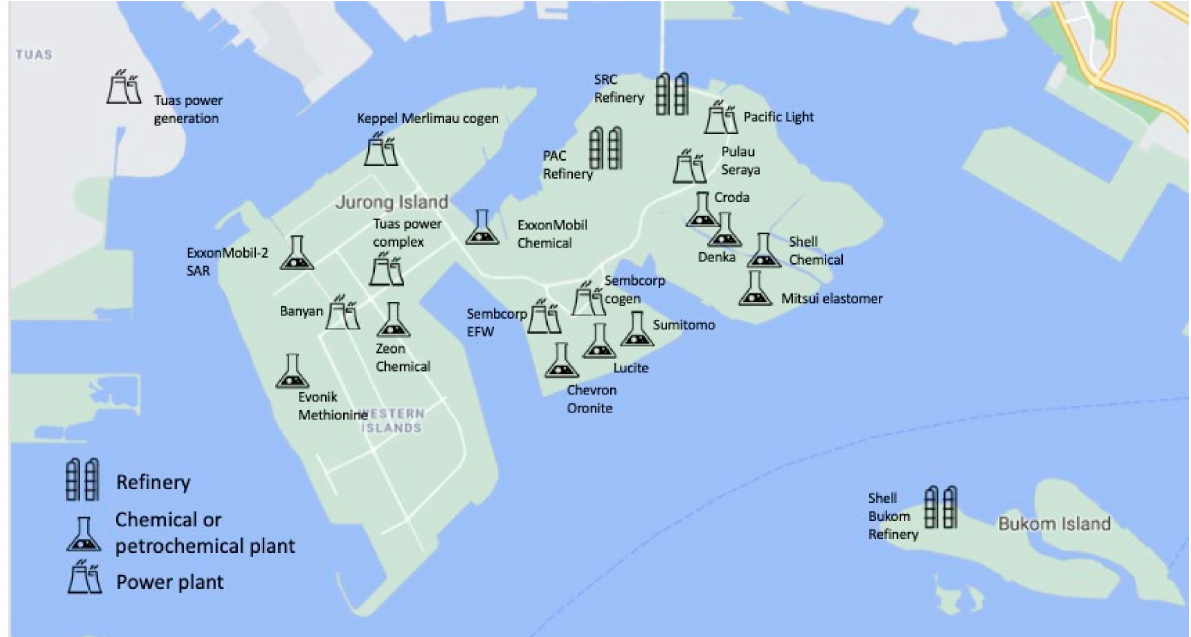
Figure 7. Major power plants, refineries, and chemical/petrochemical plants in Jurong and Bukom